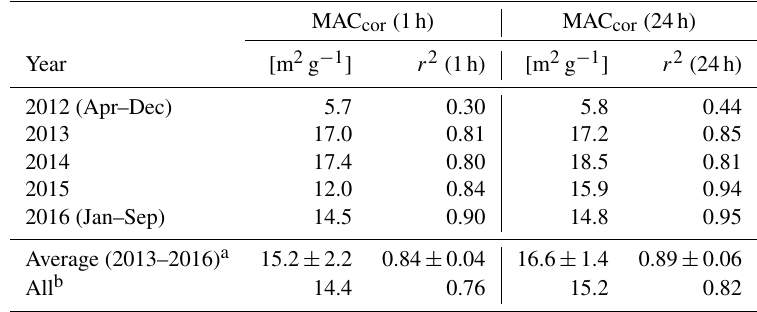
Table 6. Year-to-year variability of MAC cor (PSAP; λ = 550nm) and r 2 at Ny-Ålesund.